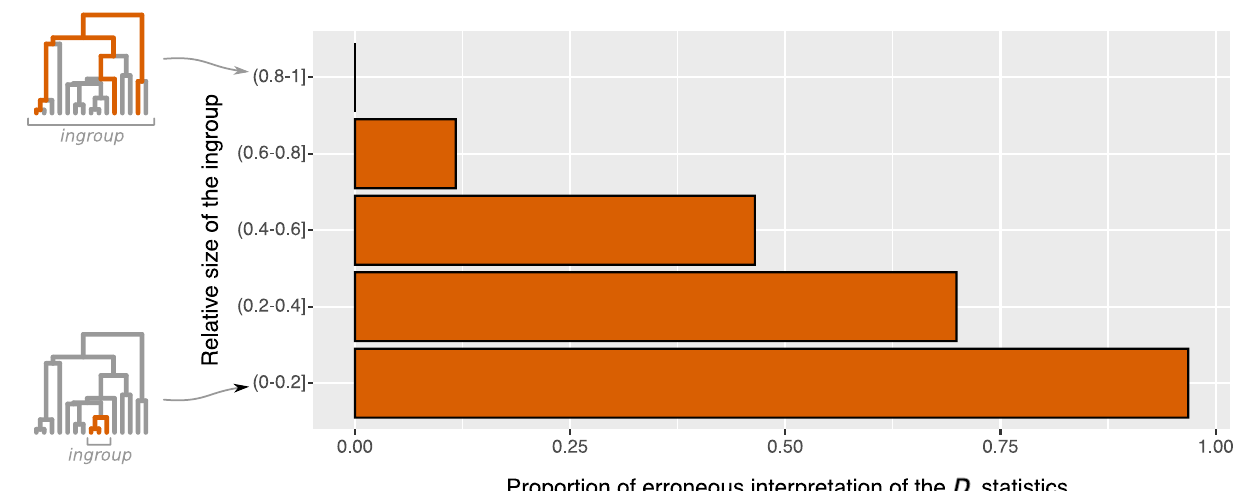
Fig 3. Proportion of cases (from simulations) where a D 3 test is significantly different from 0 because of an introgression from a ghost lineage from outside the ingroup. These cases may be incorrectly interpreted (see text) and lead to the misidentification of both taxa involved in the introgression. The proportion of erroneous interpretations of the test is computed for different relative sizes of the ingroup, i.e., the number of taxa of the smallest subtree containing the 3 taxa studied divided by the total number of taxa in the tree (see trees on the left). Data underlying this figure can be found on Zenodo (doi: 10. 5281/zenodo.6901799) and GitHub